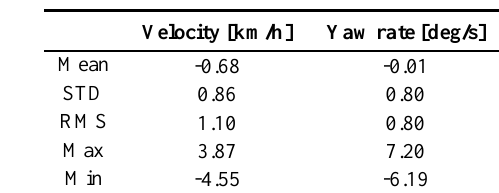
Figure 11. The yaw rate difference between in-vehicle sensor and reference data